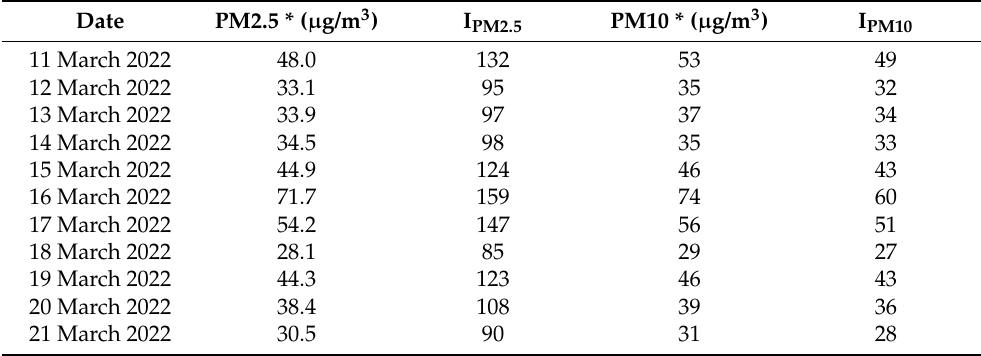
Table 9. Air Quality Index for the balcony measurement.